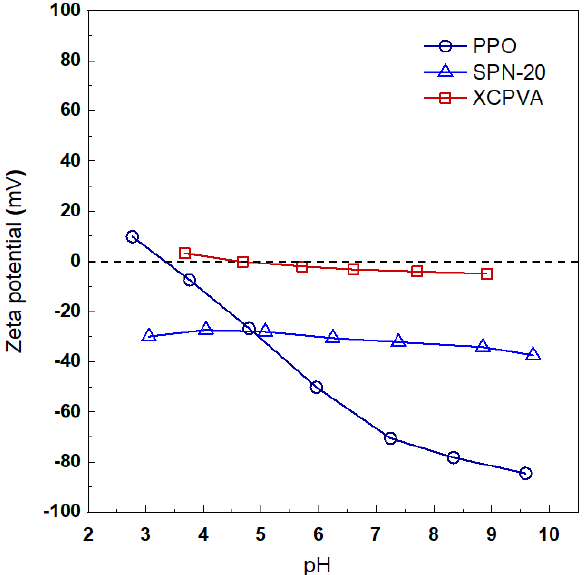
Figure 9. Zeta potential of polymeric films of PPO, SPN-20, and cross-linked CPVA layer formed on SPN-20 (XCPVA) as a function of pH measured in 1 mM KCl solution.